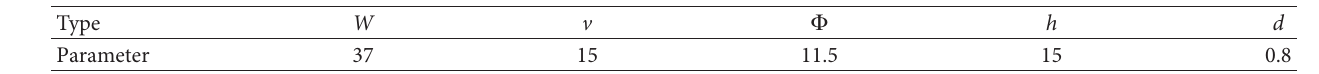
Figure 1: Schematic diagram of the test system and site layout for cutting coal pillars with DWS. (a) Layout chart and (b) A-A ′ side view. Table 1: Operating parameters of the cutting system with DWS.